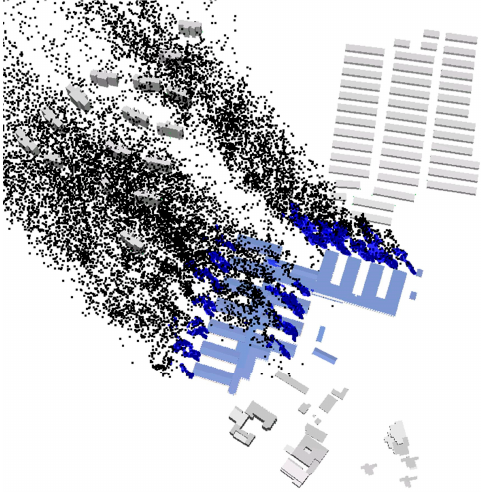
Figure 21. Visualization of the exhausted harmful air from the temporary hospital under southeast wind.